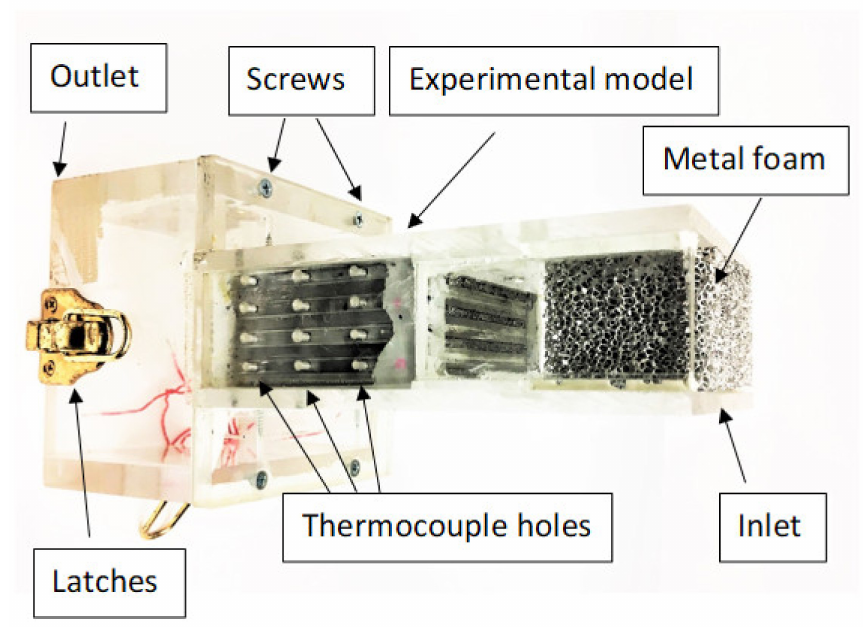
Figure 9. Complete test section before integration into the experimental